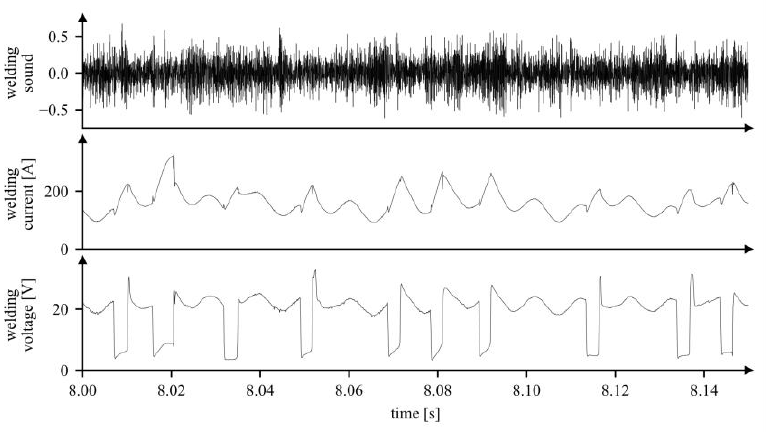
Figure 3. Comparison between the acquired welding sound, voltage and current in the middle of the weld.